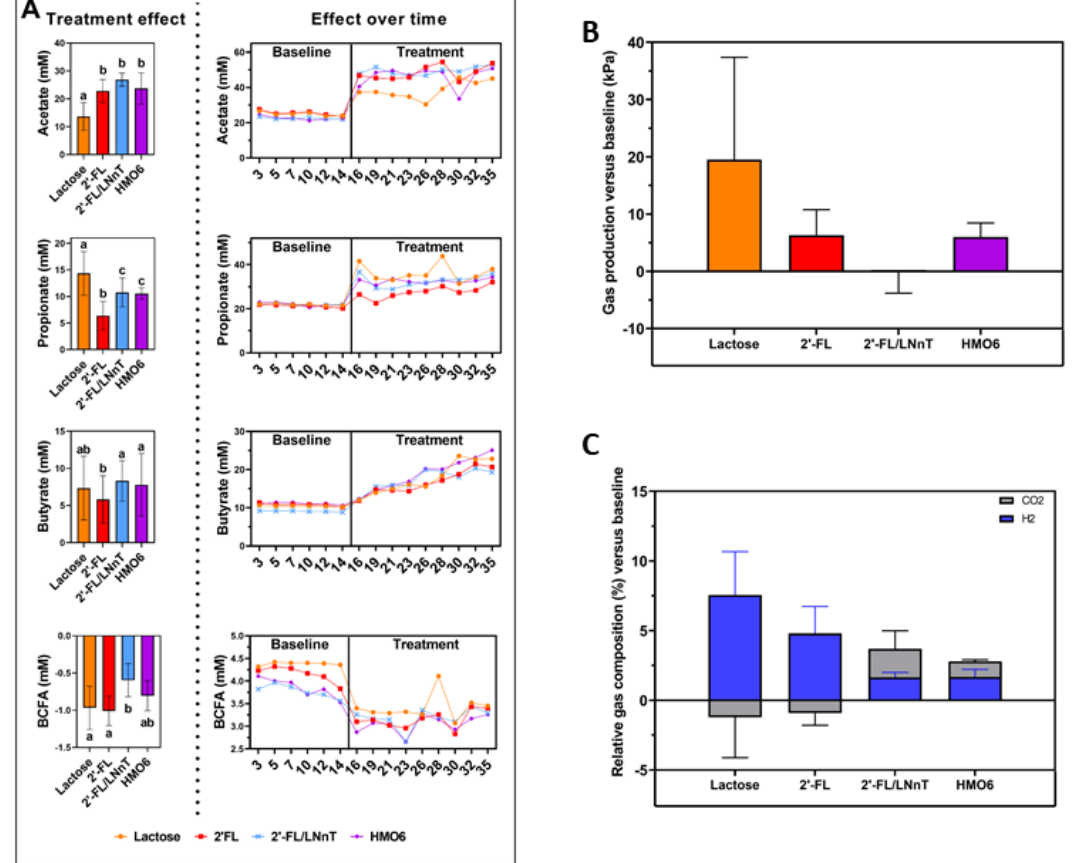
Figure 4. Effect of long-term treatment with lactose, 2 ′ -FL, 2 ′ -FL/LNnT, and HMO6 on bacterial metabolic activity. ( A ) Effect of lactose, 2 ′ -FL, 2 ′ -FL/LNnT, and HMO6 on acetate, propionate, butyrate, and BCFA levels (mM) in the distal colon. Bar plots in the left panel represent the mean ± standard deviation (SD) of the values at different time points (n = 9), after correction by the mean values for the baseline (n = 6 time points) for each reactor. This helps to observe the overall effect of each treatment after considering the effect of the baseline period. Time-course graphs in the right panel represent single measures of different metabolites at different time points. ( B ) Effect of lactose, 2 ′ -FL, 2 ′ -FL/LNnT, and HMO6 on gas production measured at day 35 of treatment and corrected by baseline values (n = 3). ( C ) Effect of lactose, 2 ′ -FL, 2 ′ -FL/LNnT, and HMO6 on the percentage of CO 2 and H 2 production measured at day 35 of treatment and corrected by baseline values (n = 3). Significant differences between treatments (one-way ANOVA with Bonferroni correction) are indicated with different letters (a, b, c; p < 0.05). Treatments sharing at least one letter are not significantly different.